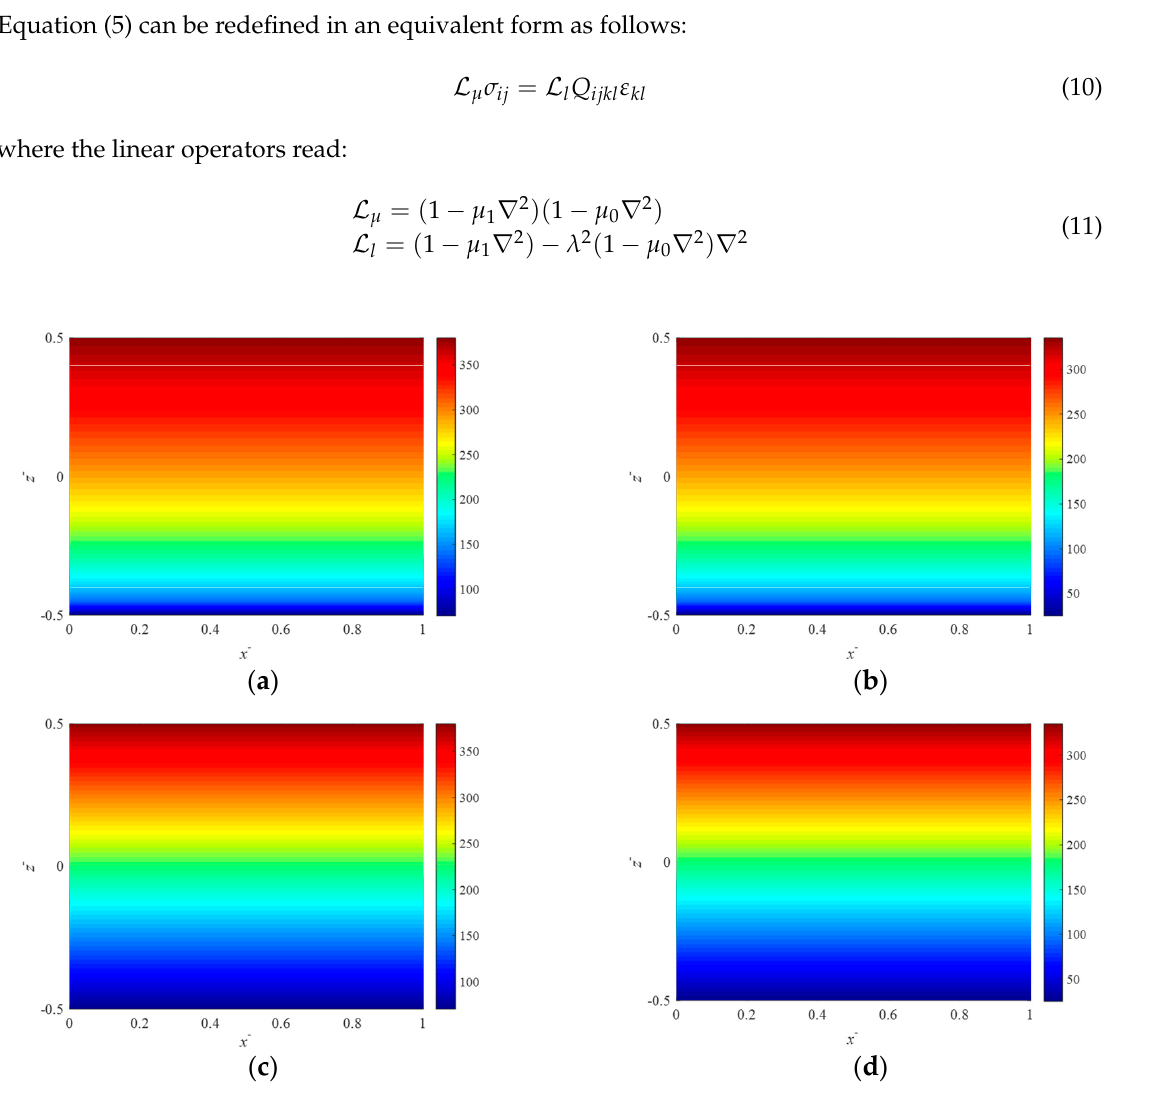
Figure 2. Distribution of the Young’s modulus for E c = 380 GPa, E m = 70 GPa at plane y = 0.5, ( a ) n = 0.5, ξ = 0.0; ( b ) n = 0.5, ξ = 0.2; ( c ) n = 1.0, ξ = 0.0; ( d ) n = 1.0, ξ =